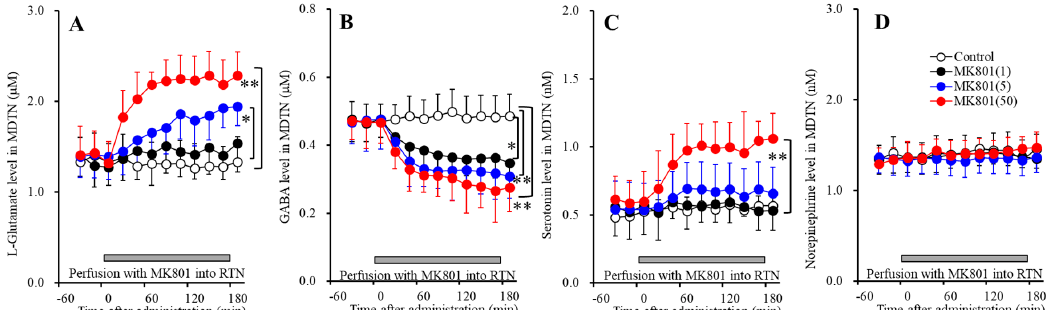
Figure 3. Concentration-dependent effects of local administration of MK801 (1, 5, and 50 μ M) into the RTN on extracellular levels of L -glutamate ( A ), GABA ( B ), serotonin ( C ), and norepinephrine ( D ) in the MDTN (Study_2). Ordinates: mean ± SD ( n = 6) of extracellular transmitter levels ( μ M or nM); abscissa: time after MK801 administration (min). Gray bars indicate perfusion with MK801 into the RTN. * p < 0.05, * p < 0.01; relative to control by MANOVA with Tukey’s post hoc test.